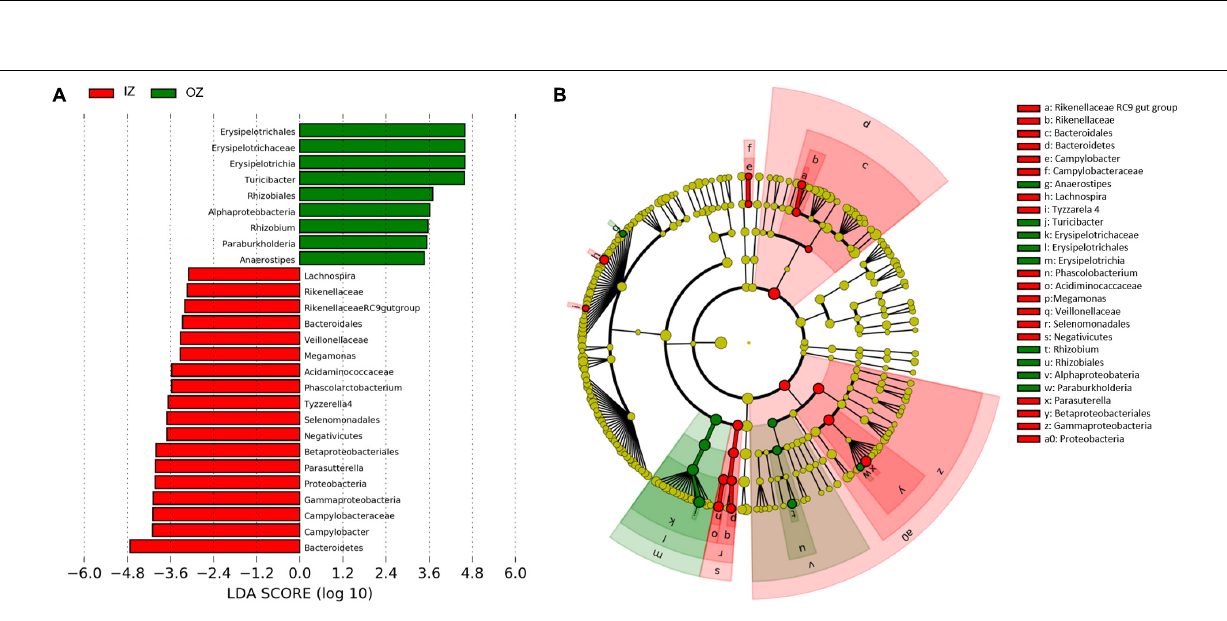
Frontiers in Microbiology |